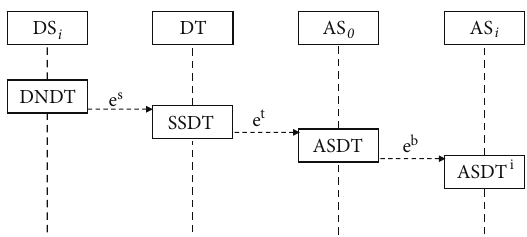
Figure 2: Schematic diagram of HMSS collaboration and data